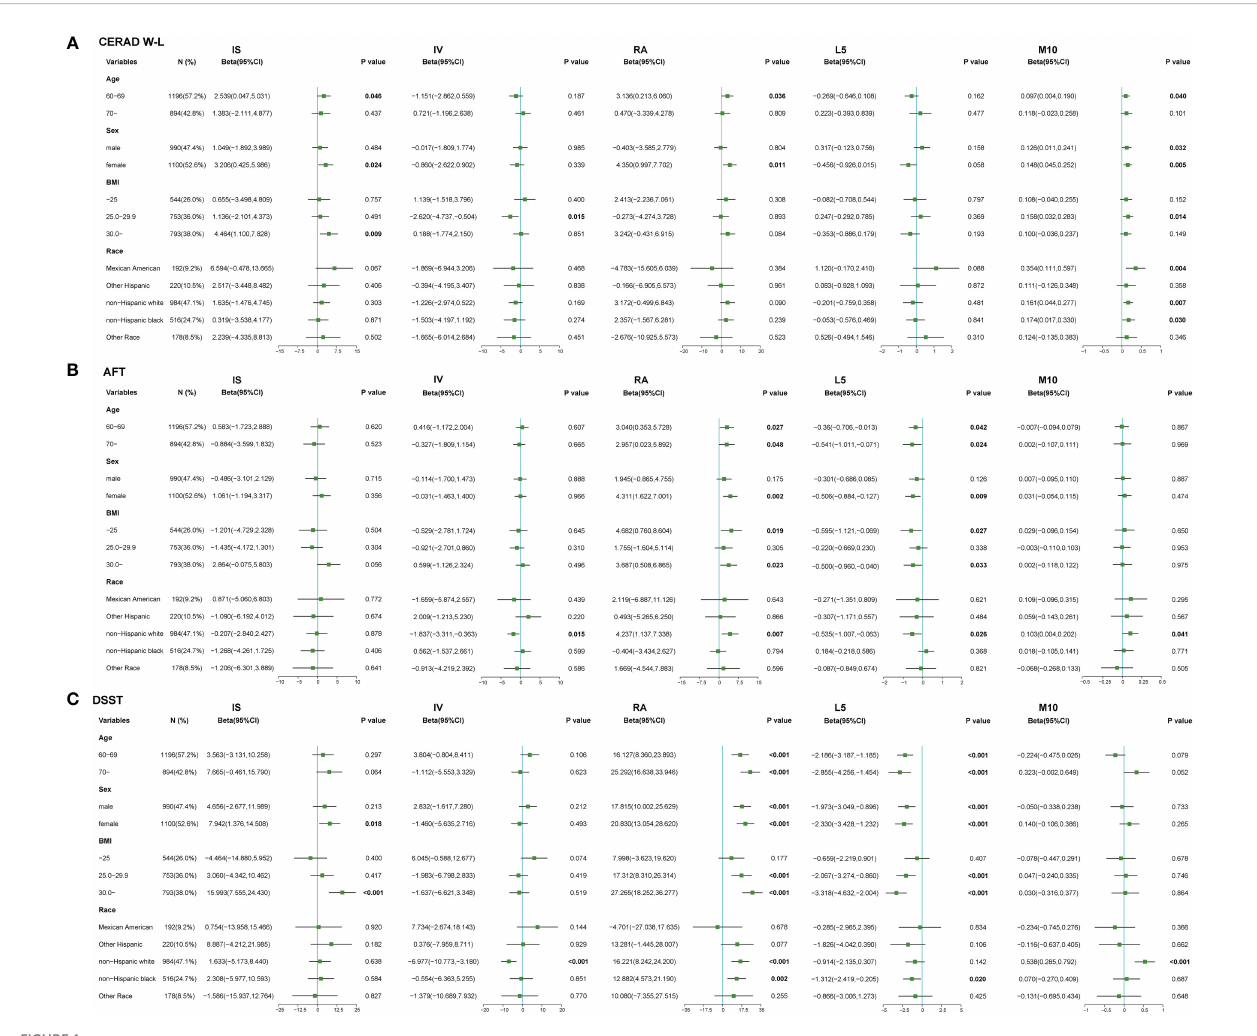
FIGURE 1 Relationships between RAR and cognitive function strati fi ed by risk factors. (A) Relationships between RAR and CERAD W-L scores in strati fi ed analysis. (B) Relationships between RAR and AFT scores in strati fi ed analysis. (C) Relationships between RAR and DSST scores in strati fi ed analysis. Results were adjusted for age (60-69, ≥ 70), sex (male, female), BMI (<25, 25-29.9, ≥ 30 kg/m 2 ), race (Mexican American, other Hispanic, non-Hispanic white, non- Hispanic black, others). Dots indicate beta estimates, and black horizontal lines indicate 95%